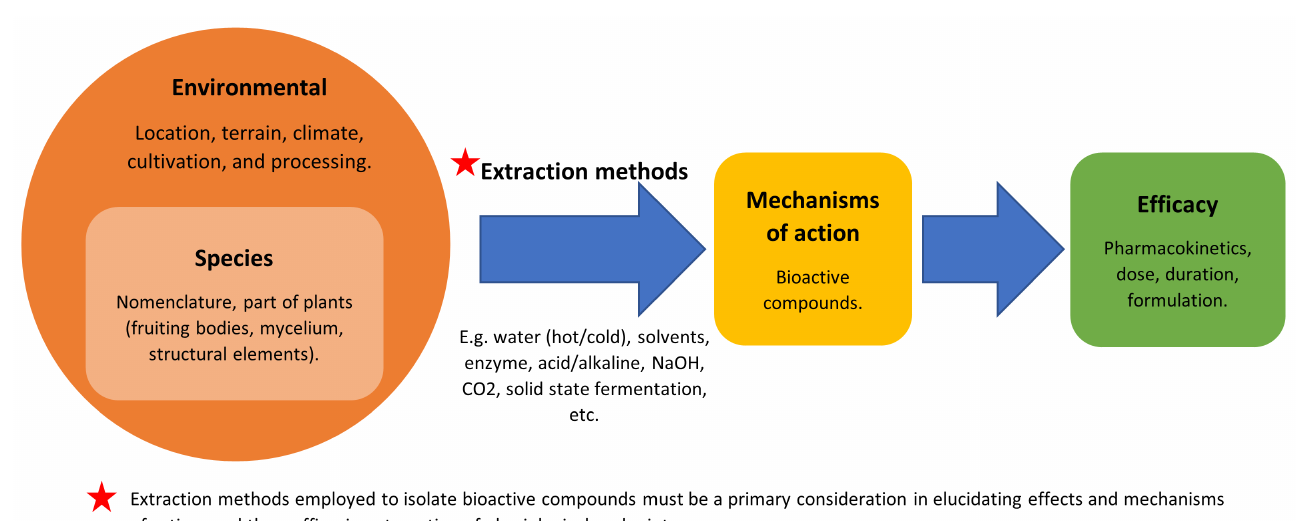
Figure 2. Factors to consider if medicinal mushrooms are to be utilised for therapeutic and treat- ment